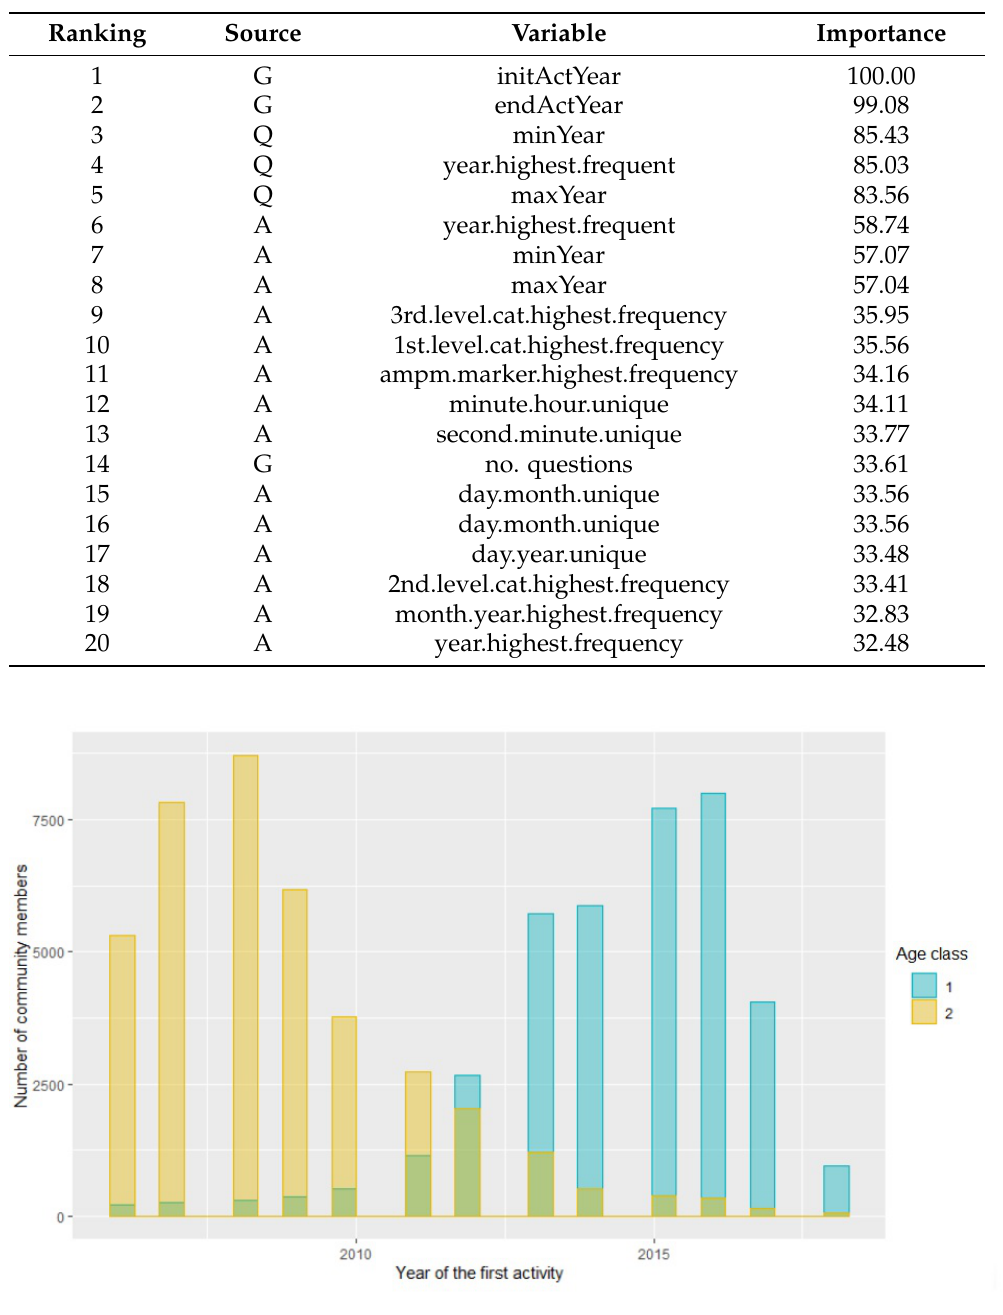
Table 6. The top 20 most important variables (out of 95). The values are scaled between 0 and 100. Q, A and G denote elements extracted from questions, answers and global (combines all information), respectively (see variable descriptors on Appendix A).